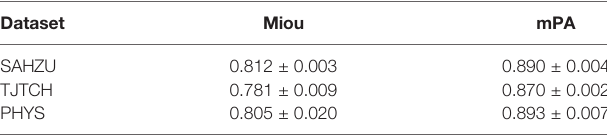
TABLE 2 | Mean Intersection-over-union and Mean Pixel Accuracy in Three Medical Centers.